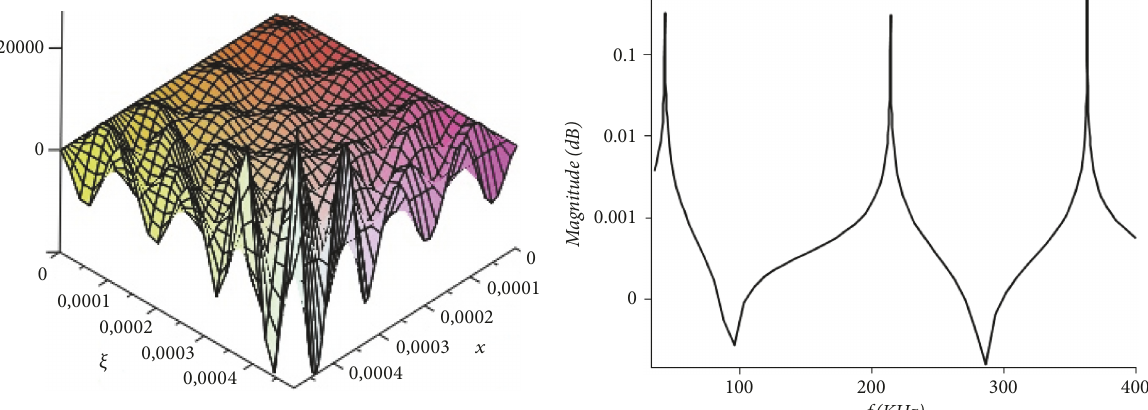
Figure 5: Left: frequency function 𝐻(𝑖𝜔 6 ,𝑥, 𝜉) . Right: modal frequency response 𝐻(𝑖𝜔,𝑥 𝑜 , 𝜉 𝑜 ) with the first three natural frequencies: 46.2𝐾𝐻𝑧 , 222.9𝐾𝐻𝑧 , and 376.2𝐾ℎ𝑧 at a given